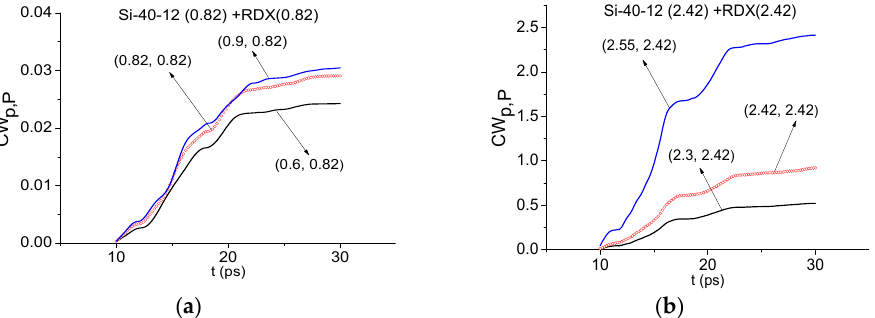
Figure 13. Integral characteristics CW p,P ( t n ) calculated for the frequencies ν = 0.82 THz ( a ); 2.42 THz ( b ) THz for Si-40-12 signal with RDX_Air as a standard one.